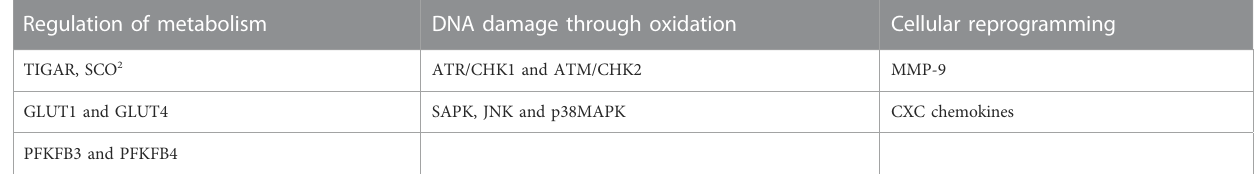
TABLE 3 A summary of roles of p53 in different processes involved in osteosarcoma. Even though some of these processes do not unfold in typical and atypical ferroptosis, they are vital in explaining the roles of p53 in osteosarcoma. Regulation of metabolism